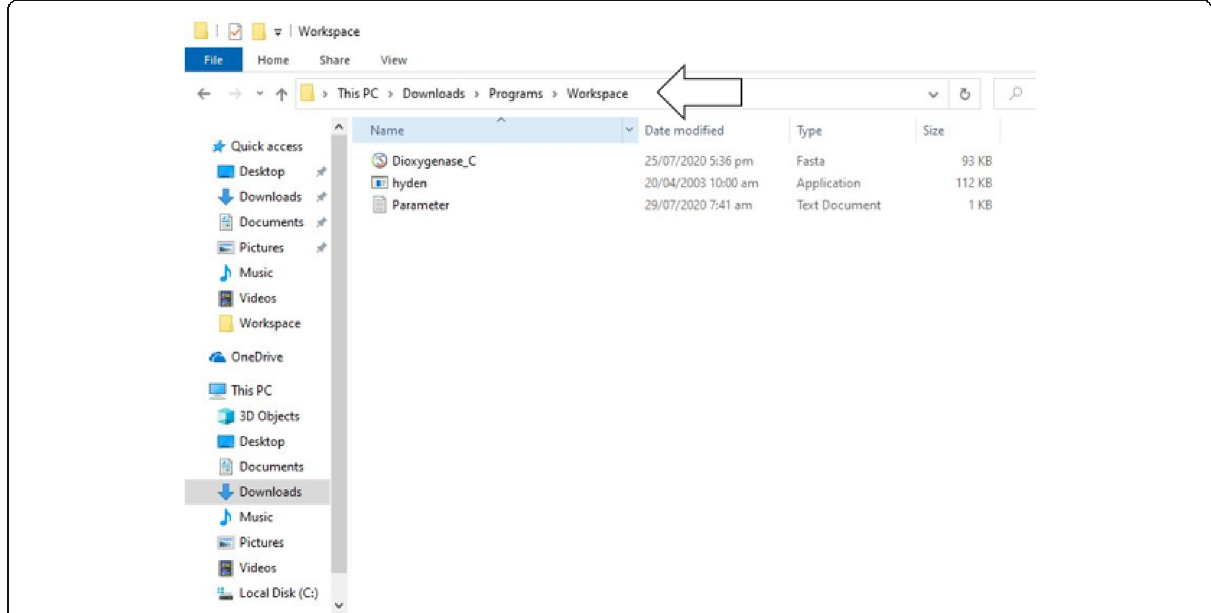
Fig. 6 Screenshot illustrating the working folder created for degenerate primer design